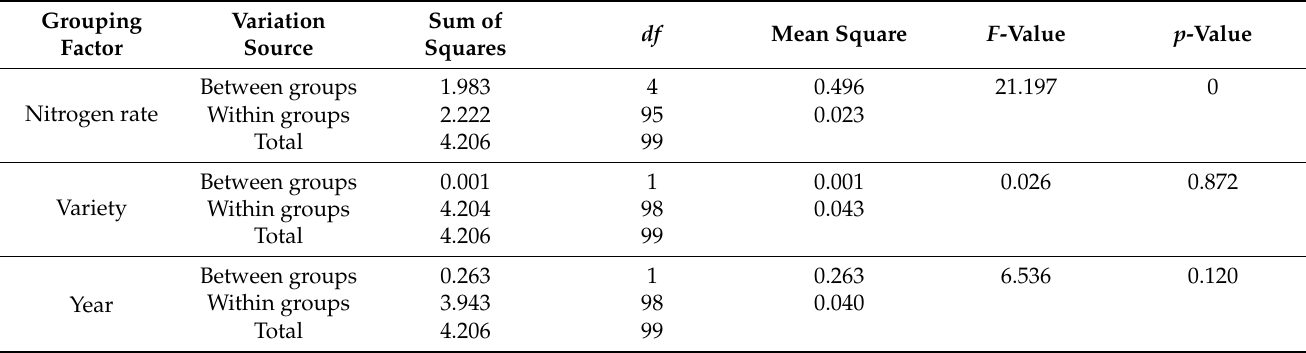
Table 2. Analysis of variance for the NNI LAI with respect to the variety, nitrogen rates, and